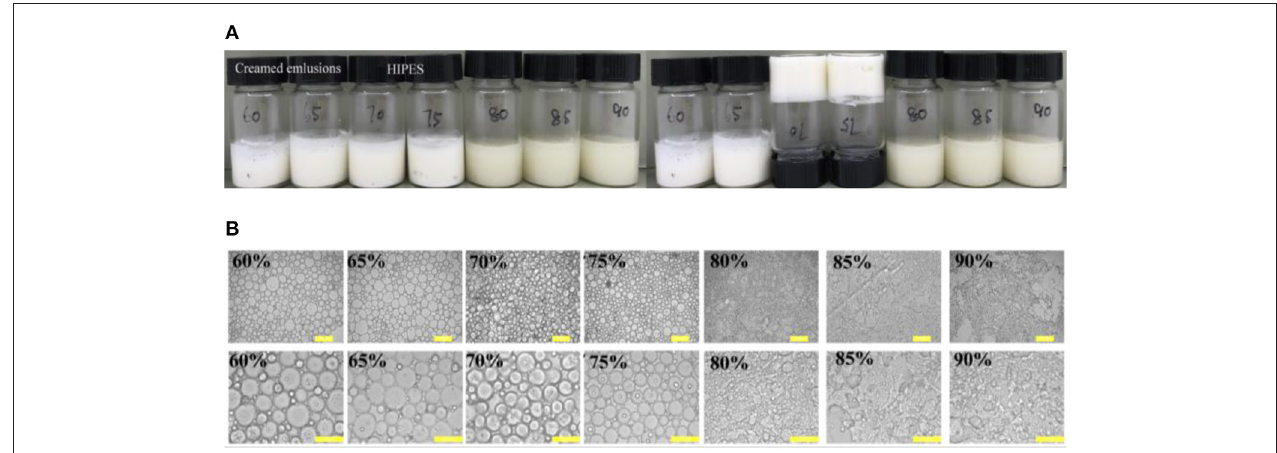
FIGURE 1 | Visual appearance (A) and optical micrographs (B) of freshly prepared water-soluble protein (WSP)-stabilized emulsion by the protein at a constant solid concentration (3 wt%) in the aqueous phase, but varying soy oil fractions φ values of 60–90%. The pH and salt concentrations were 7 and 0mM, respectively. The scale bars are 100 and 50 µ m, respectively.